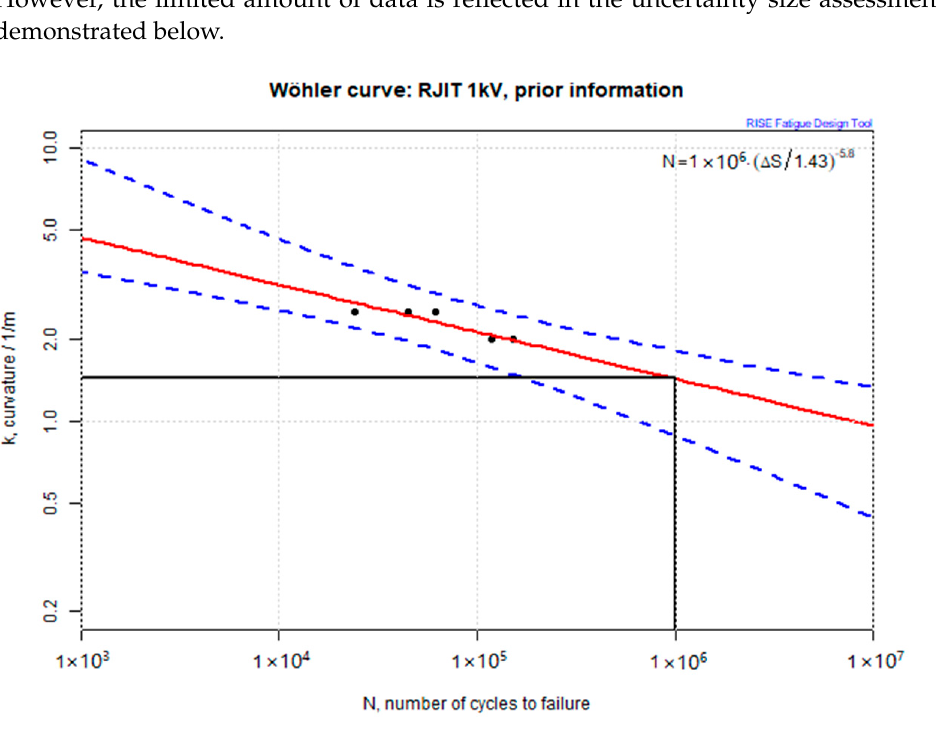
Figure 7. Estimated Wöhler curve of the cable, using prior knowledge on the exponent m , where the circles are experimental data, the solid line is the estimated Wöhler curve, and the dashed lines the 95% confidence intervals.